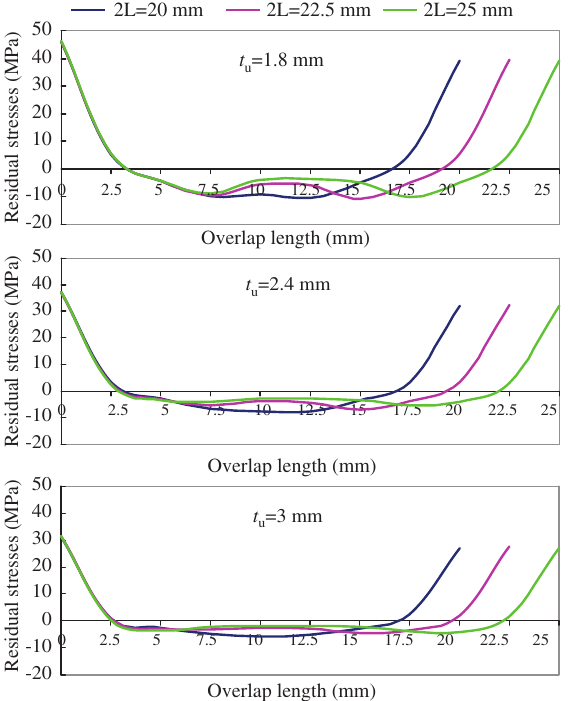
Figure 10 Effect of adherends’ thickness on the residual shear stress for adhesive length of 2 L = 22.5 mm with different adhesive thickness.